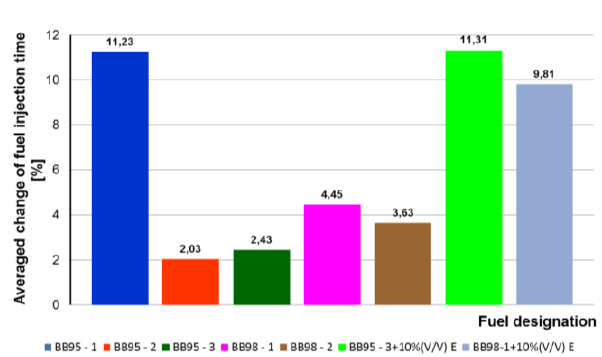
Fig. 4. Comparison of the results of the DISI engine injector deposit tendency evaluations according to the CEC F-113-KC